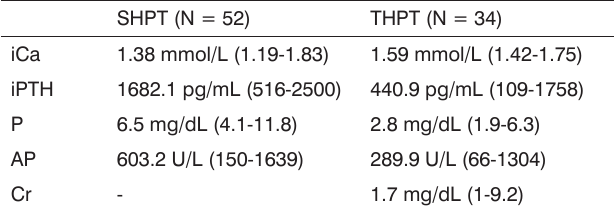
Table 2. Patient pre-operative laboratory data.